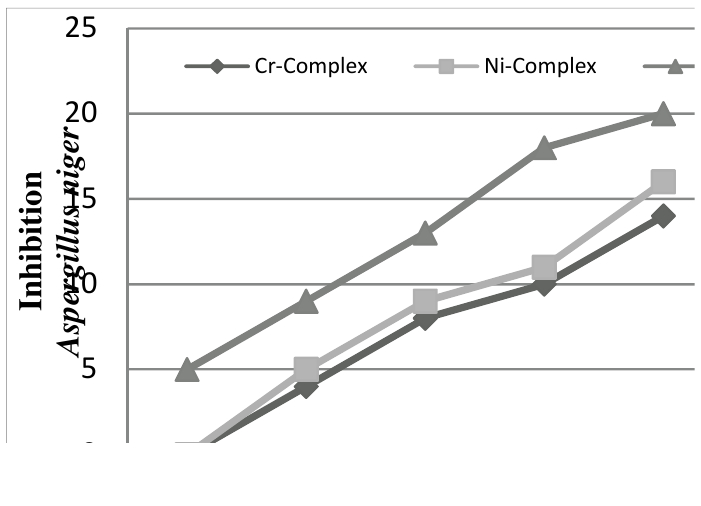
Figure 7. The effect of complexes toward Aspergillus niger